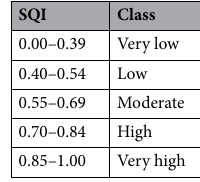
Table 1. Comprehensive soil quality index (SQI) classification